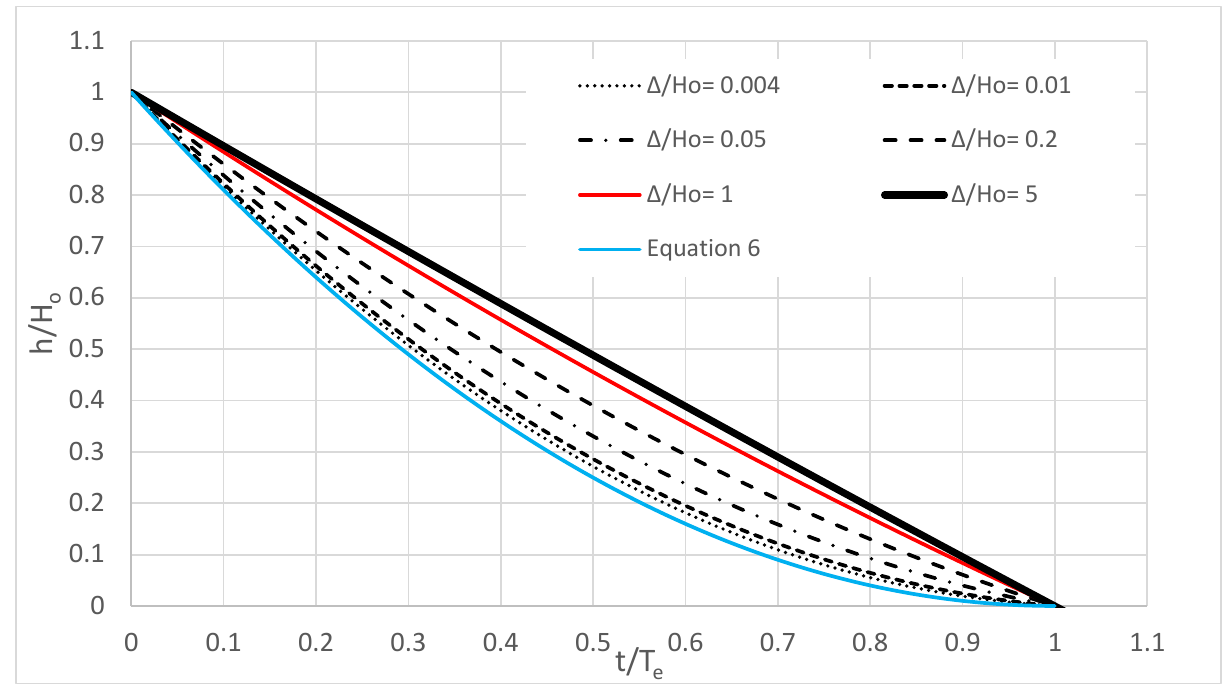
Figure 5. Effect of ∆/Ho ratio on the decline trends for the tank water depth (tank-pipe-outlet system) .